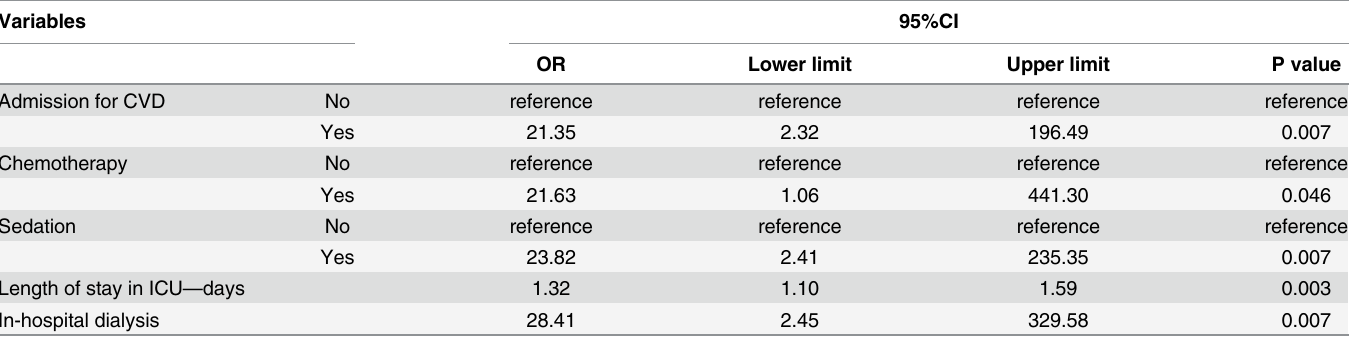
Table 5. Risk factors associated with death: multivariate